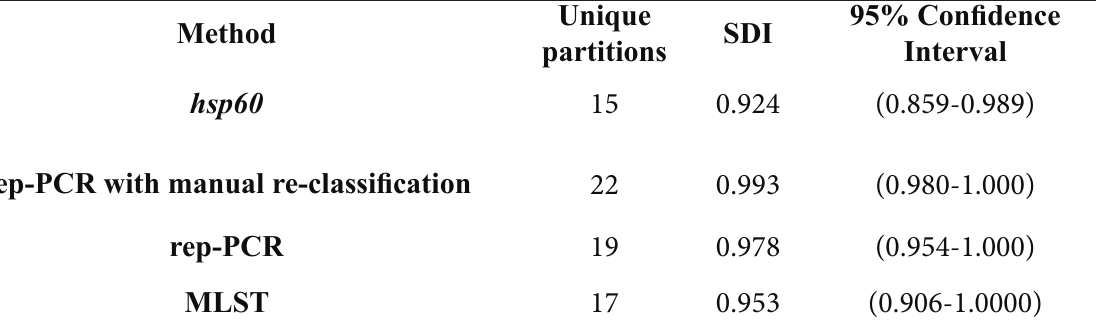
Table 3. Simpson’s Diversity Index (SDI) for rep-PCR, hsp60 sequencing, and MLST with 24 iso-